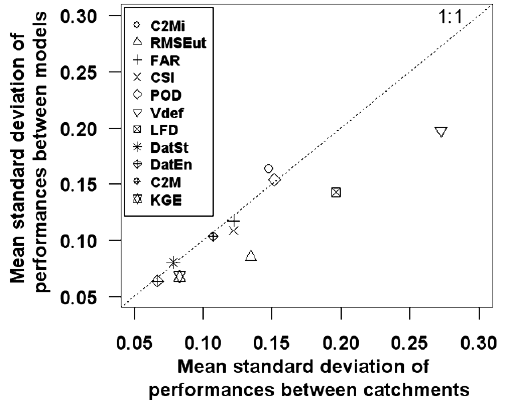
Figure 6. Comparison of the variability (expressed by the stan- dard deviation) in mean performance on all models per catchment ( x axis) and the variability in mean performance on all catchments per model ( y axis), in simulation for the 21 selcted performance criteria.